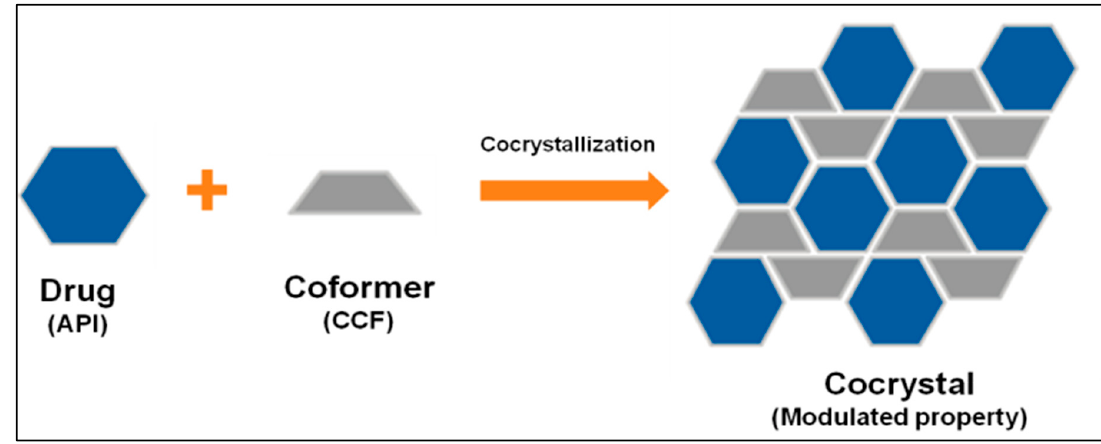
Figure 1. Typical representation of preparation of cocrystal.